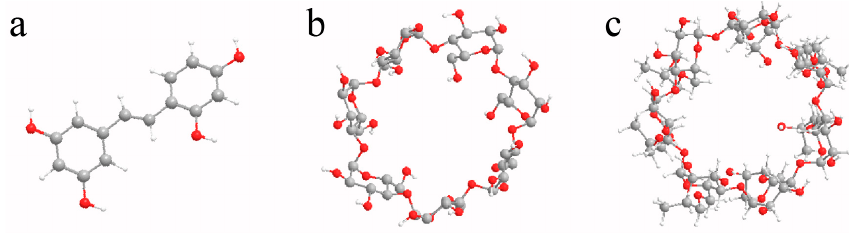
Figure 1 . 3D molecule structures of oxyresveratrol ( a ); β -CD ( b ); HP- β -CD ( c ). Figure 1. 3D molecule structures of oxyresveratrol ( a ); β -CD ( b ); HP- β -CD ( c